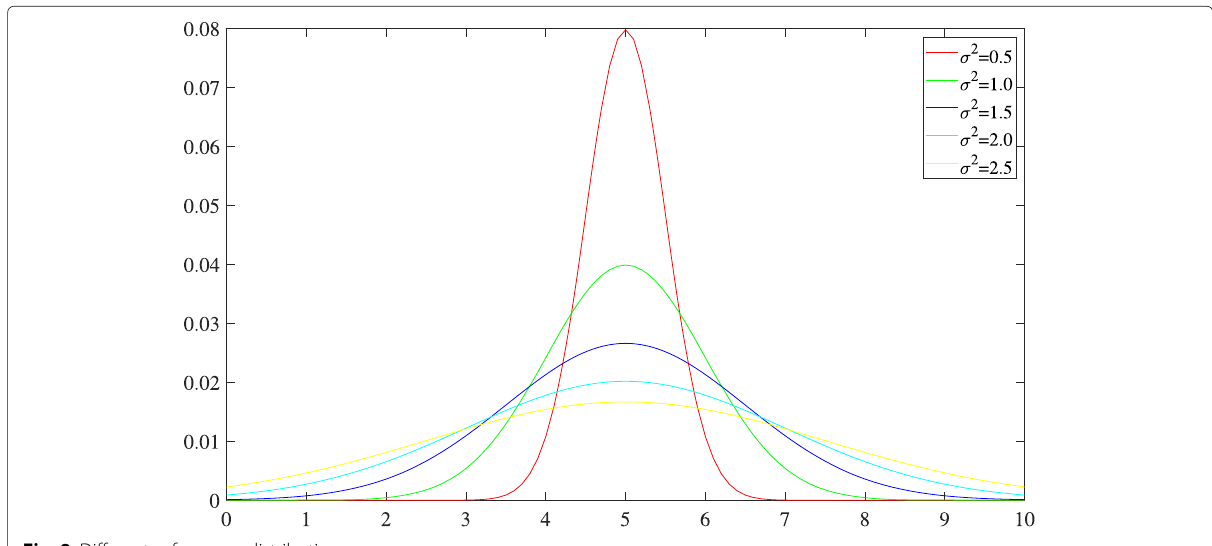
Fig. 8 Different σ for gauss